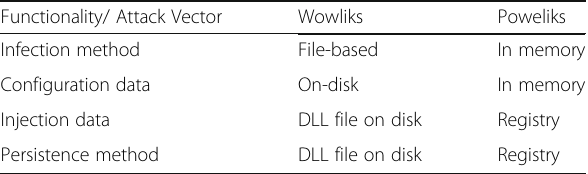
Table 4 The Evolution of